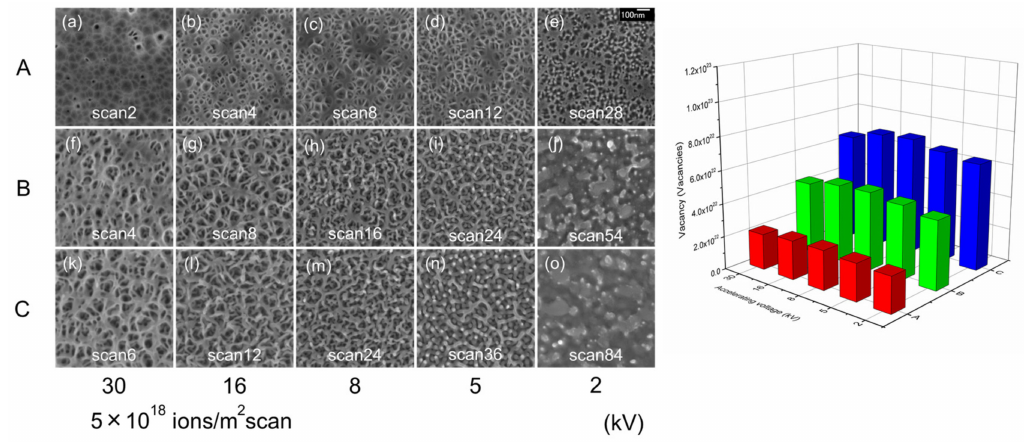
Figure 2. Surface SEM images of GaSb irradiated with a Ga + ion beam at room temperature ( left ). The accelerating voltages used were 2, 5, 8, 16, and 30 kV at a scanning dose of 5 × 10 18 ions/m 2 per scan. The total number of vacancies created on GaSb was estimated using the ion dose (ions/m 2 ) multiplied by the vacancy count (/ion) as calculated by SRIM simulations, as a function of accelerating voltage ( right